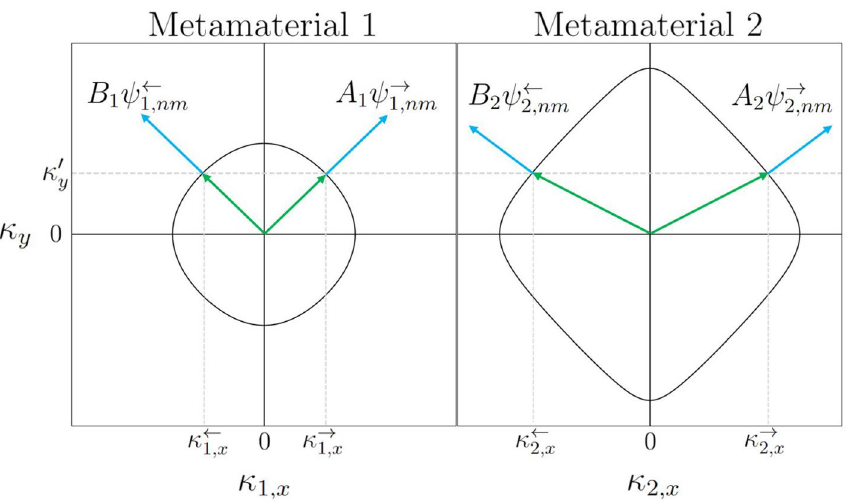
1 / l for a scattering matrix with =